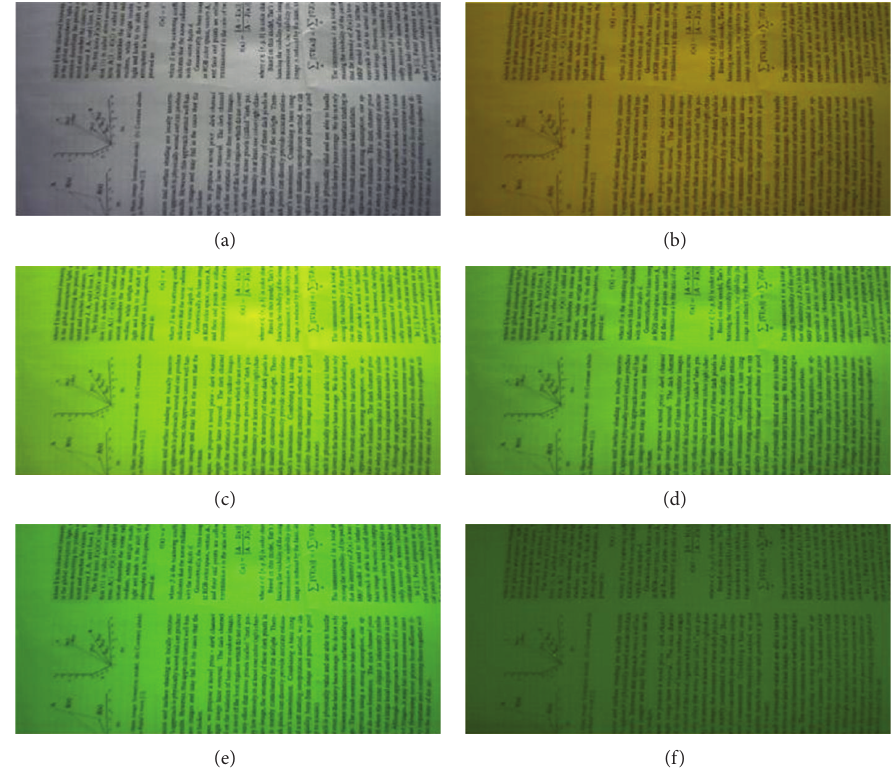
Figure 3: Black-and-white images under different color lights; (a) image with automatic white balance (AWB) to show the truth image, (b)– (e) images without AWB in color temperature: F 2700 K, L84 4000 K, D50T 5000 K, and D65T 6500 K, and (f) image without AWB in natural light.